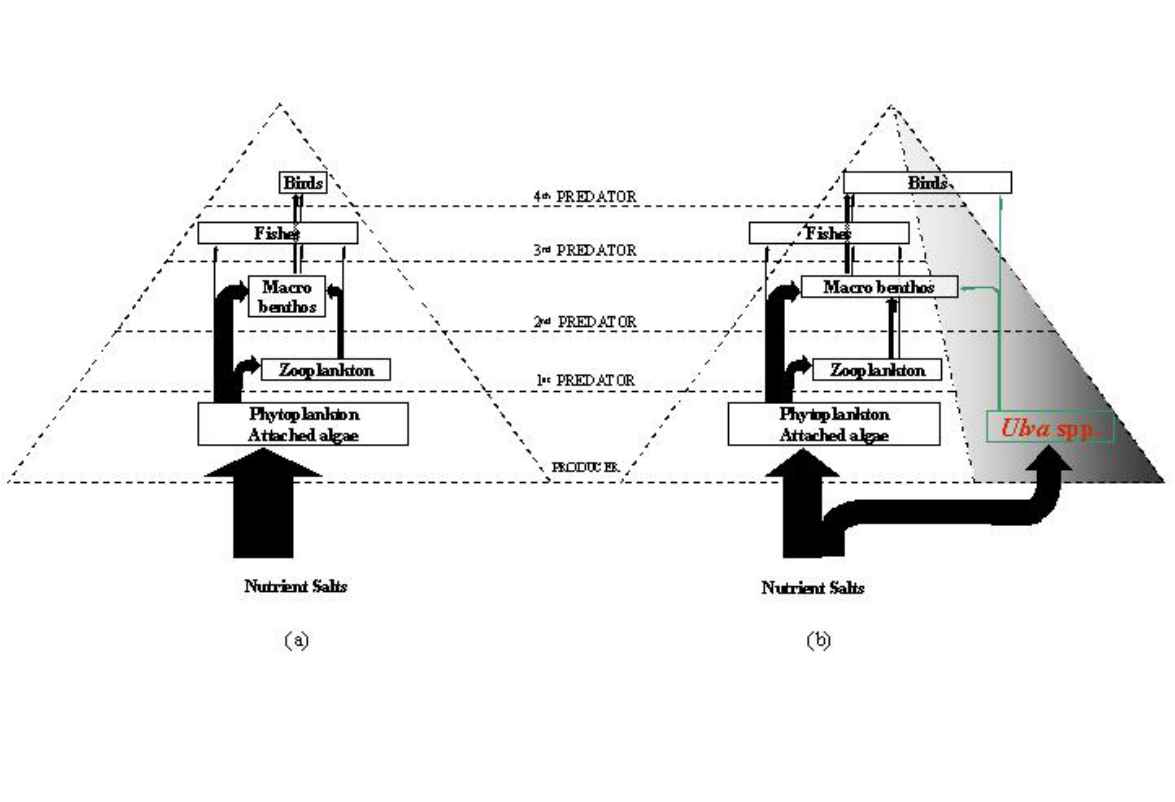
FIGURE 4. Transition of ecosystem structure on Yatsu tidal flat. The thickness of arrows is shown relative importance of nutrient salts